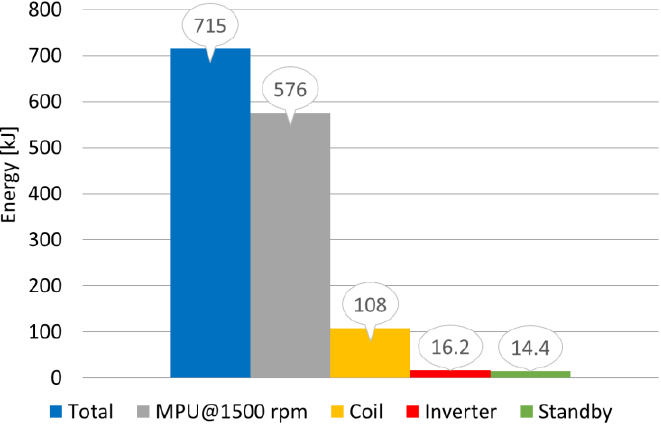
( b ) Figure 6. Energy consumption distribution: ( a ) conventional drive, ( b ) EHD. In further analysis, energy consumption was divided into two components — con- stant and variable. The first one includes standby mode, supply to valve coils, MPU, and frequency inverter energies. These magnitudes are the result of the duration of the cycle. It is worth paying attention to how much energy these elements consume within an hour